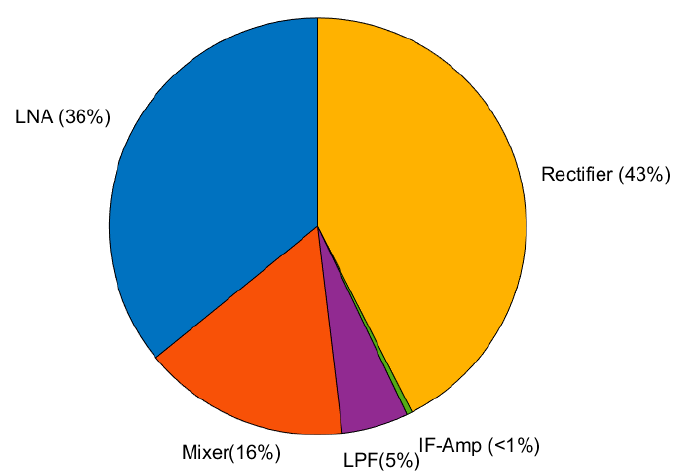
Figure 20. Power-breakdown chart. The total current consumption is 15.4 mA at V DD = 1.8